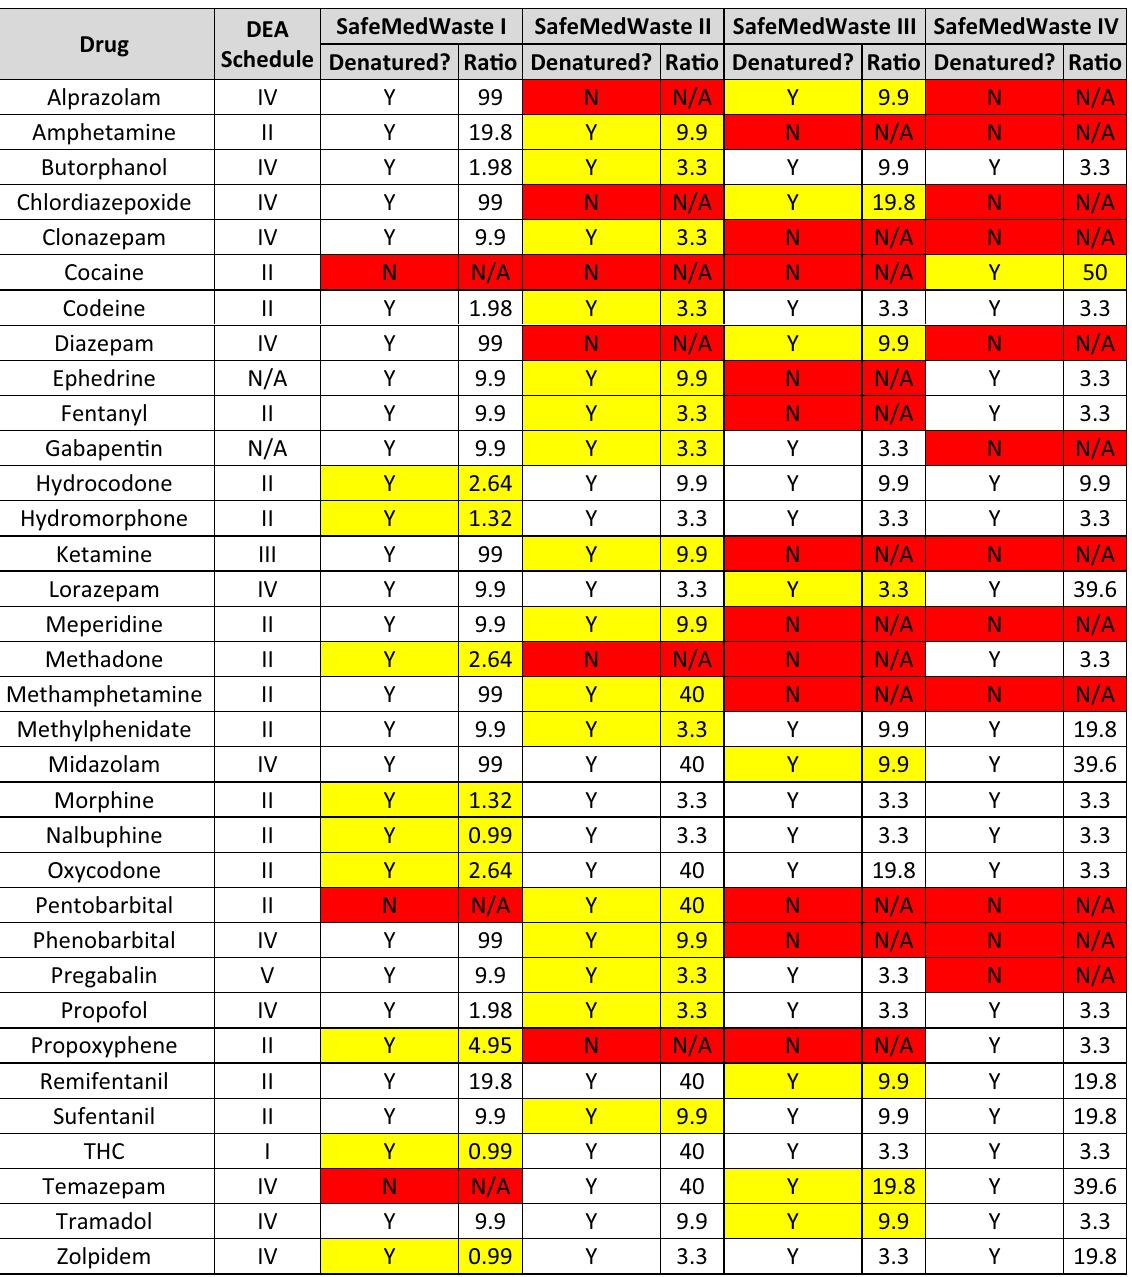
Table 2. Compatibility of 34 drugs with SafeMedWaste formulations I–IV. Y = yes, N = no. Cells highlighted yellow indicate that formulation of SafeMedWaste is the most efficient formulation (in terms of both efficacy and cost) for that drug. Cells highlighted red indicate incompatibility, in that the drug was not fully denatured in the indicated formulation of SafeMedWaste. The ratios are the amount of SafeMedWaste active ingredients (in grams) required to denature 1 g of controlled